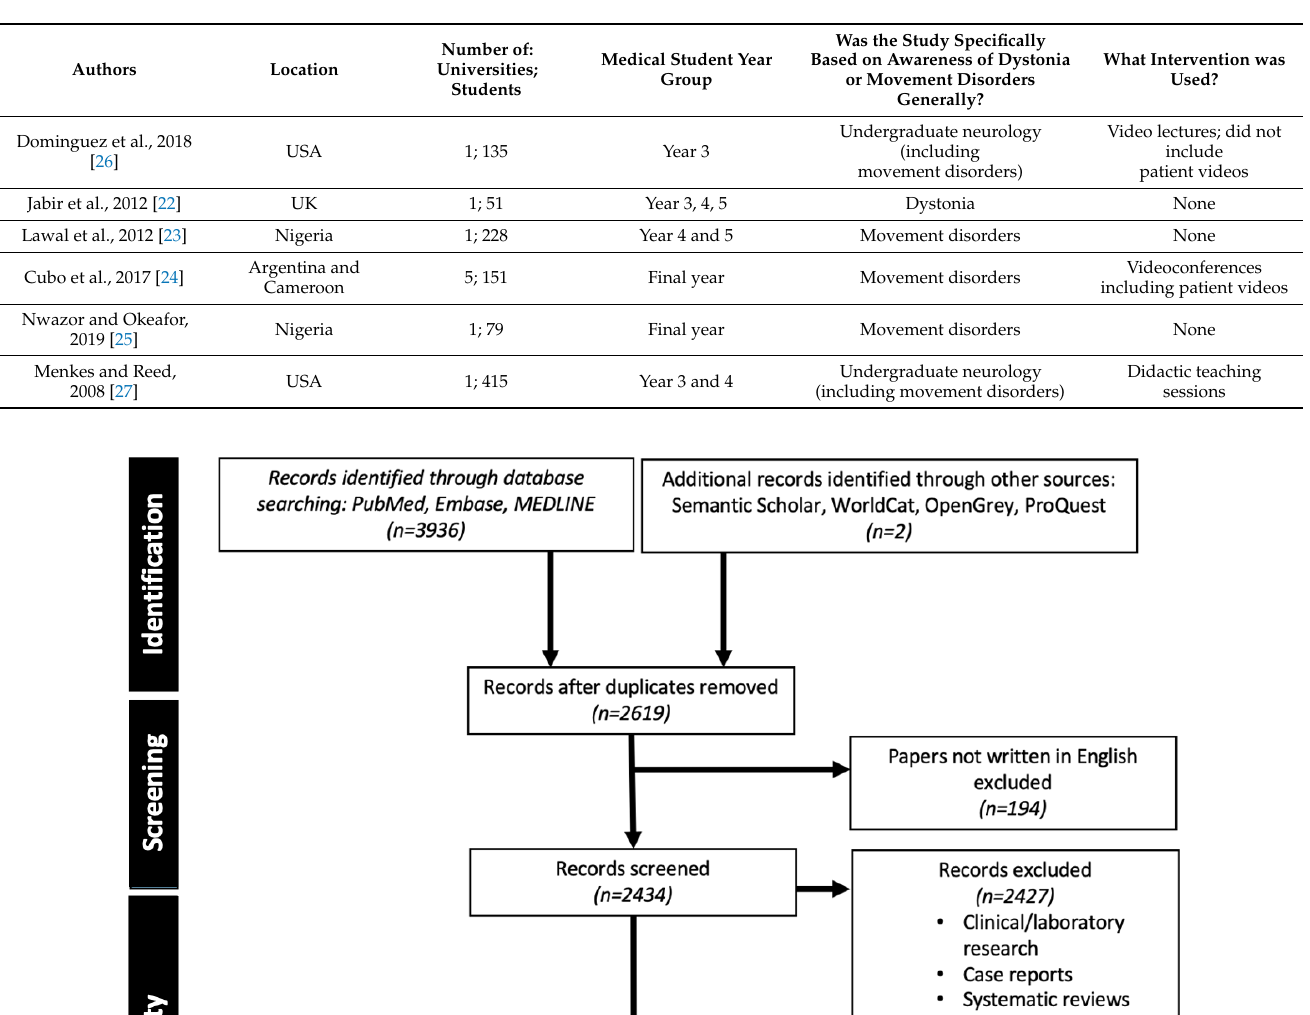
Table 1. Characteristics of the studies included within the systematic review.